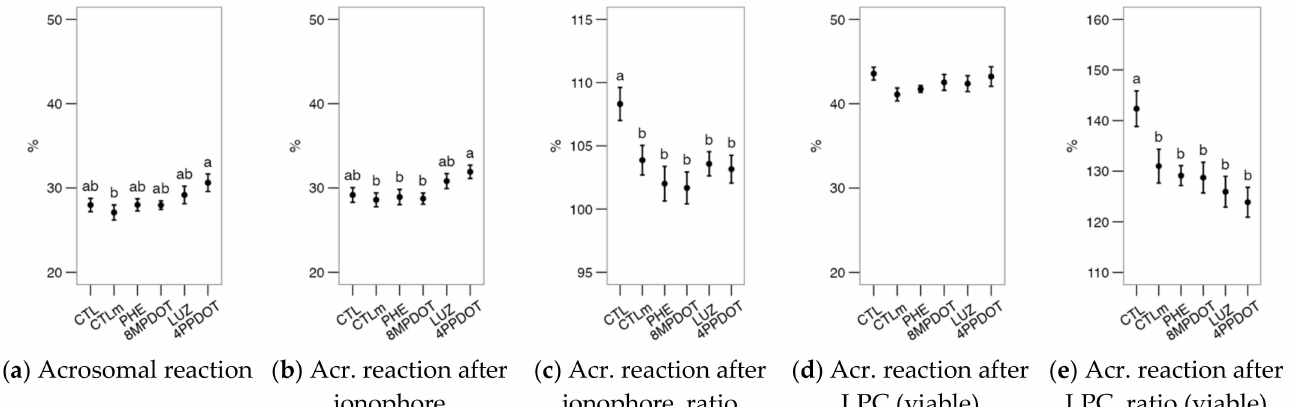
Figure 3. Effects on bull sperm acrosomal reaction (within the viable population) of melatonin receptors agonists (PHE: Phenylmelatonin; 8MPDOT: 8-Methoxy-2-propionamidotetralin) or antago- nists with 10 nM melatonin (LUZ: Luzindole; 4PPDOT: cis-4-Phenyl-2-propionamidotetralin); CTL: Control; CTLm: Control with 10 nM melatonin. Plots show mean ± SEM for each treatment of seven males. ( a ) Acrosomal reaction (PNA + cells) in neat, ( b ) after ionophore treatment, and ( c ) as a ratio of the values after ( b ) and before ( a ) the challenge; and ( d ) after lysophosphatidylcholine (LPC) treatment, and ( e ) as a ratio of the values after ( d ) and before ( a ) the challenge. Treatments not sharing the same letters differ significantly ( p <